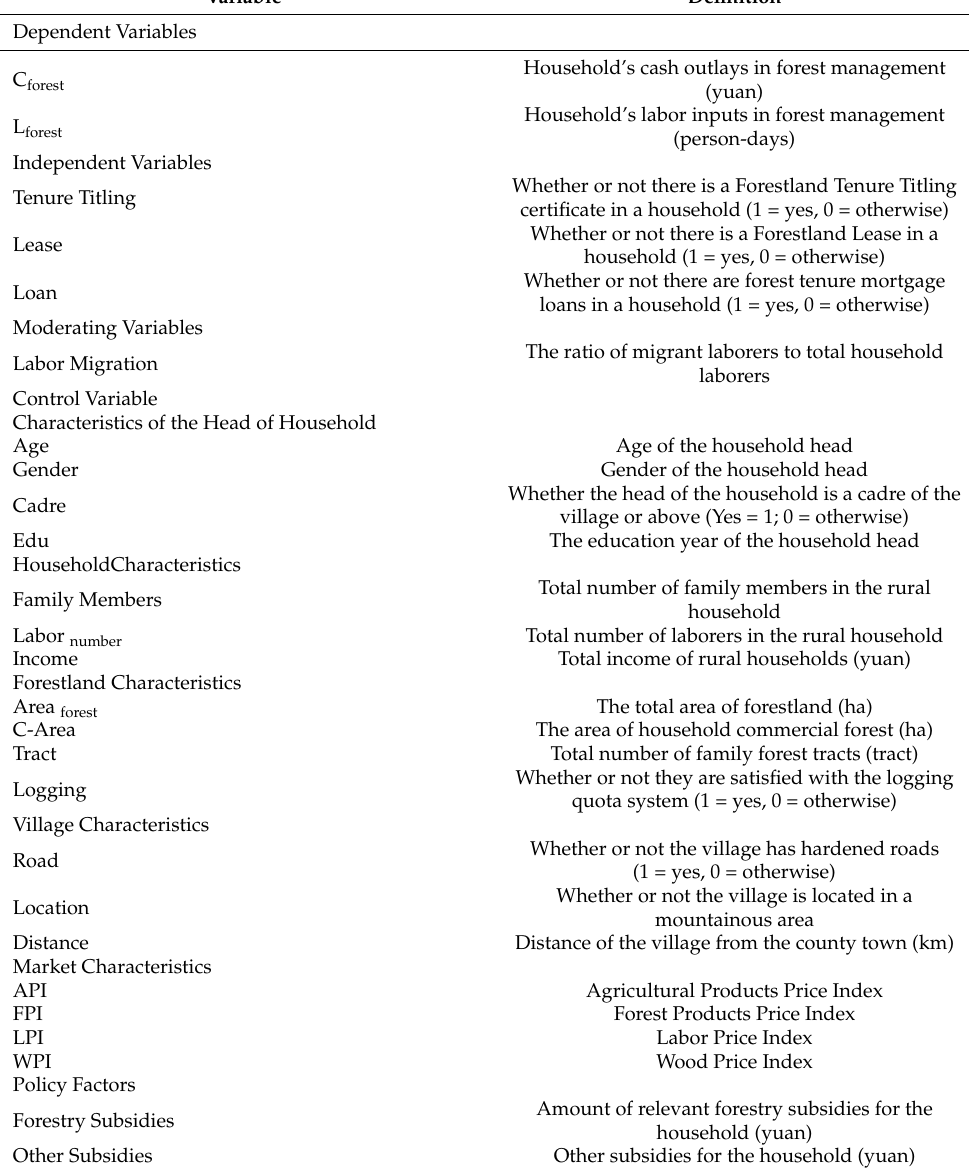
Table 1. The definitions of the variables involved in the